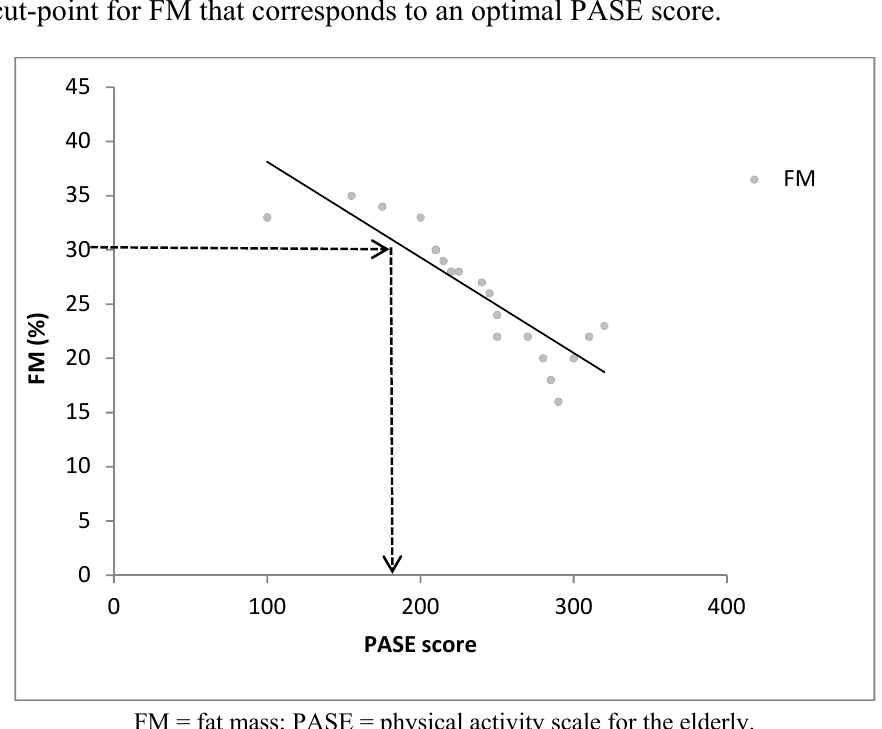
Figure 1. Stylized relationship between FM and PASE score. Arrows represent the male healthy cut-point for FM that corresponds to an optimal PASE score.